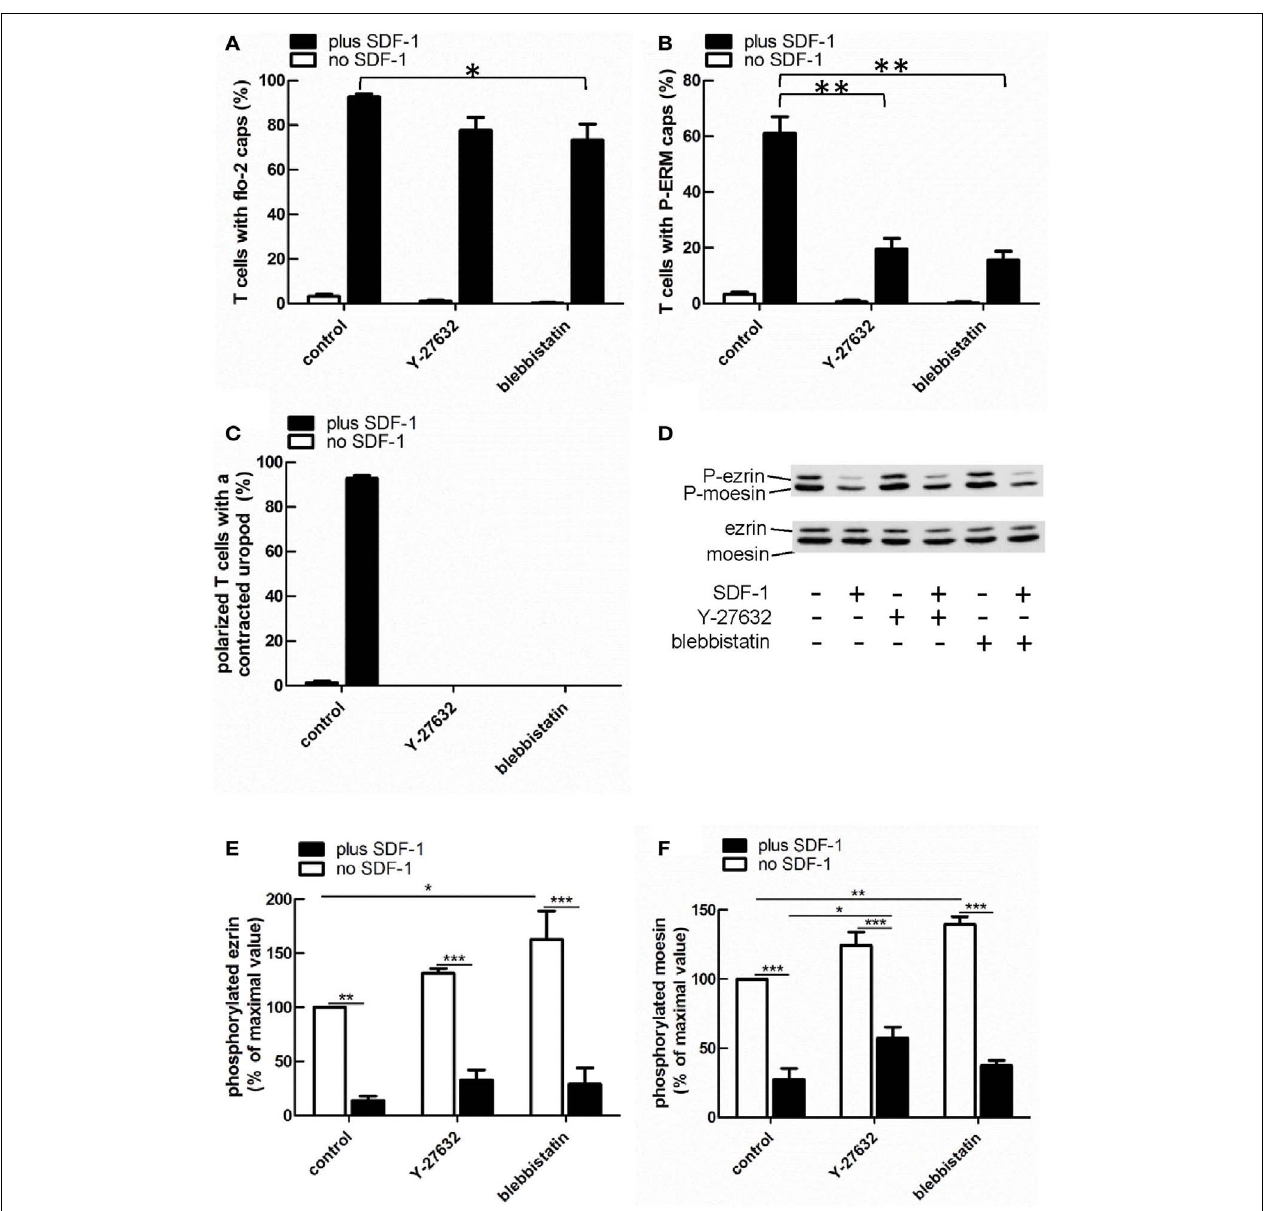
FIGURE 8 | Impact of cytoskeletal perturbation on capping of endogenous flotillin-2 and P-ERM and on humanT cell front-tail polarity induced by SDF-1. (A–C) T cells were preincubated for 30min in the absence or presence of 20 µ MY-27632 or 50 µ M blebbistatin or 1 µ M latrunculin A, followed by a further incubation in the absence or presence of SDF-1 (40ng/ml) for 15min.T cells were then fixed withTCA and stained for flotillin-2 and P-ERM.The % ofT cells with flotillin-2 caps (A) and P-ERM caps (B) and the % of cells with front-tail polarity featuring contracted uropods (C) was evaluated (mean ± SEM of three independent experiments). * P < 0.05, ** P < 0.01, for statistically significant differences between data as indicated.